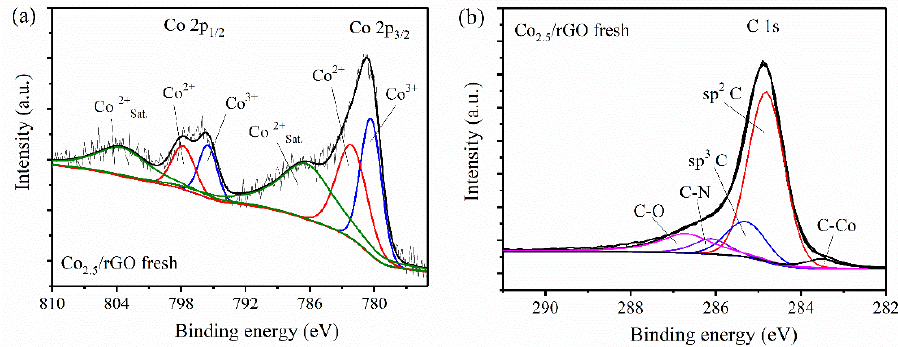
Figure 2. XPS characterization of Co 2.5 /rGO catalyst: ( a ) energy spectrum of Co 2p; ( b ) energy spectrum of C1s.